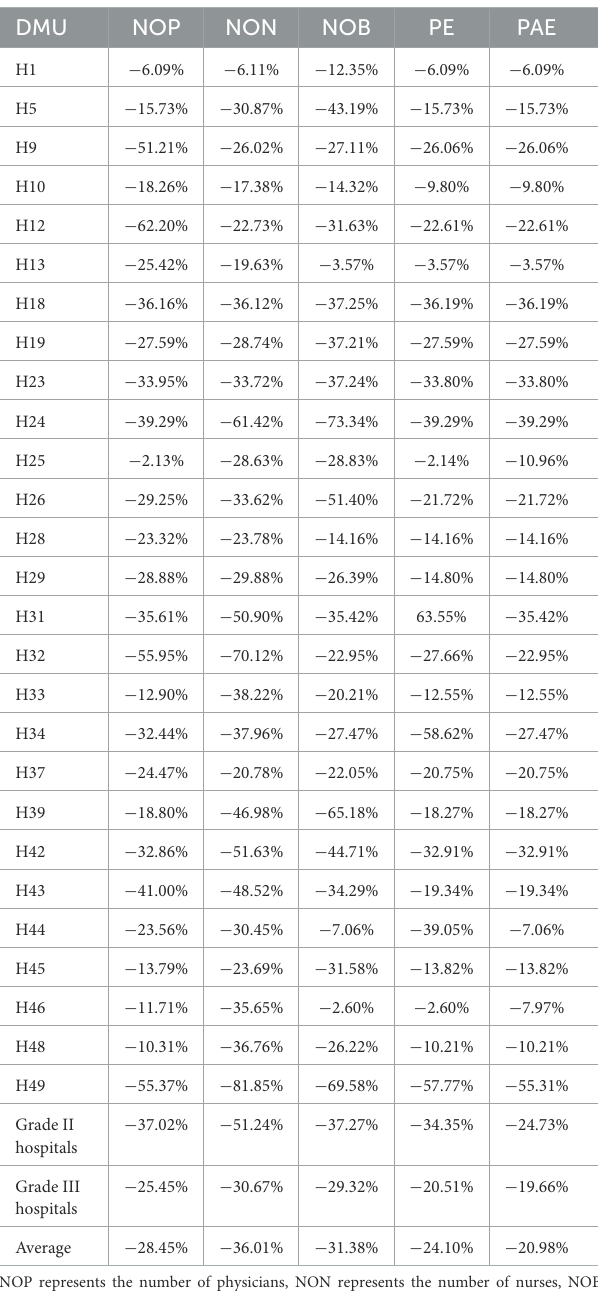
TABLE 8 Relaxation assessment of average input of ineffective